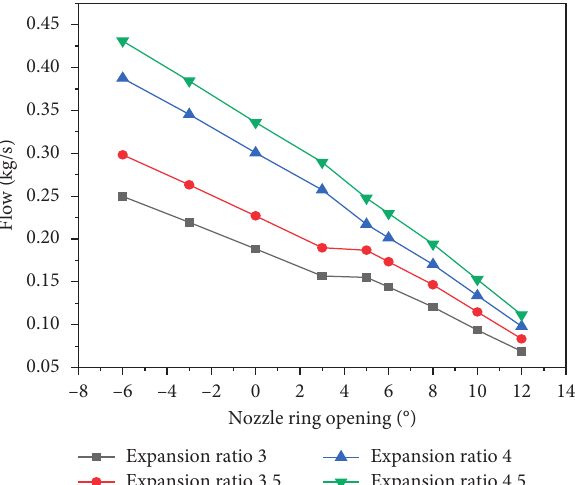
Figure 32: Relationship between opening and torque.